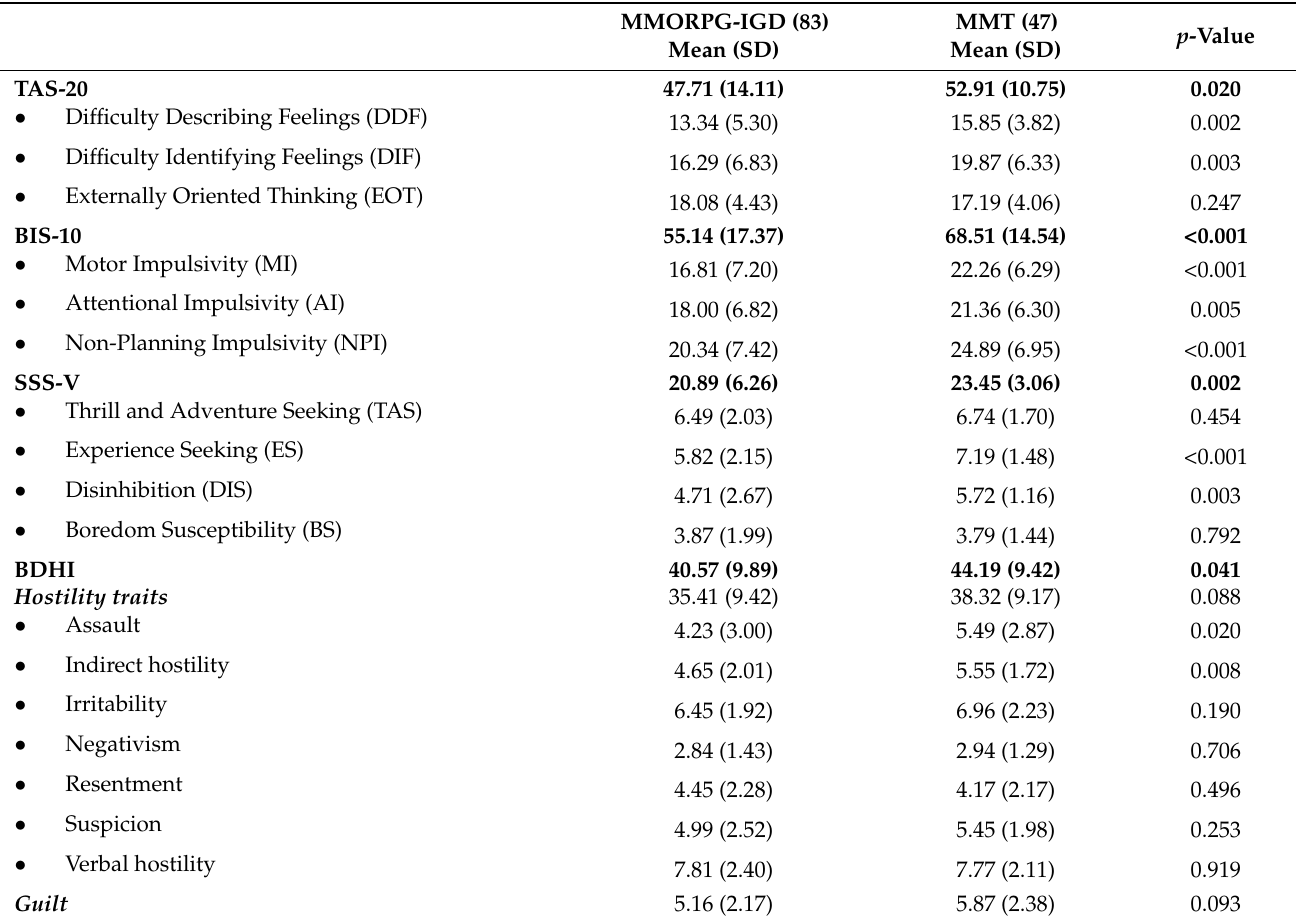
Table 3. Comparison of psychometric